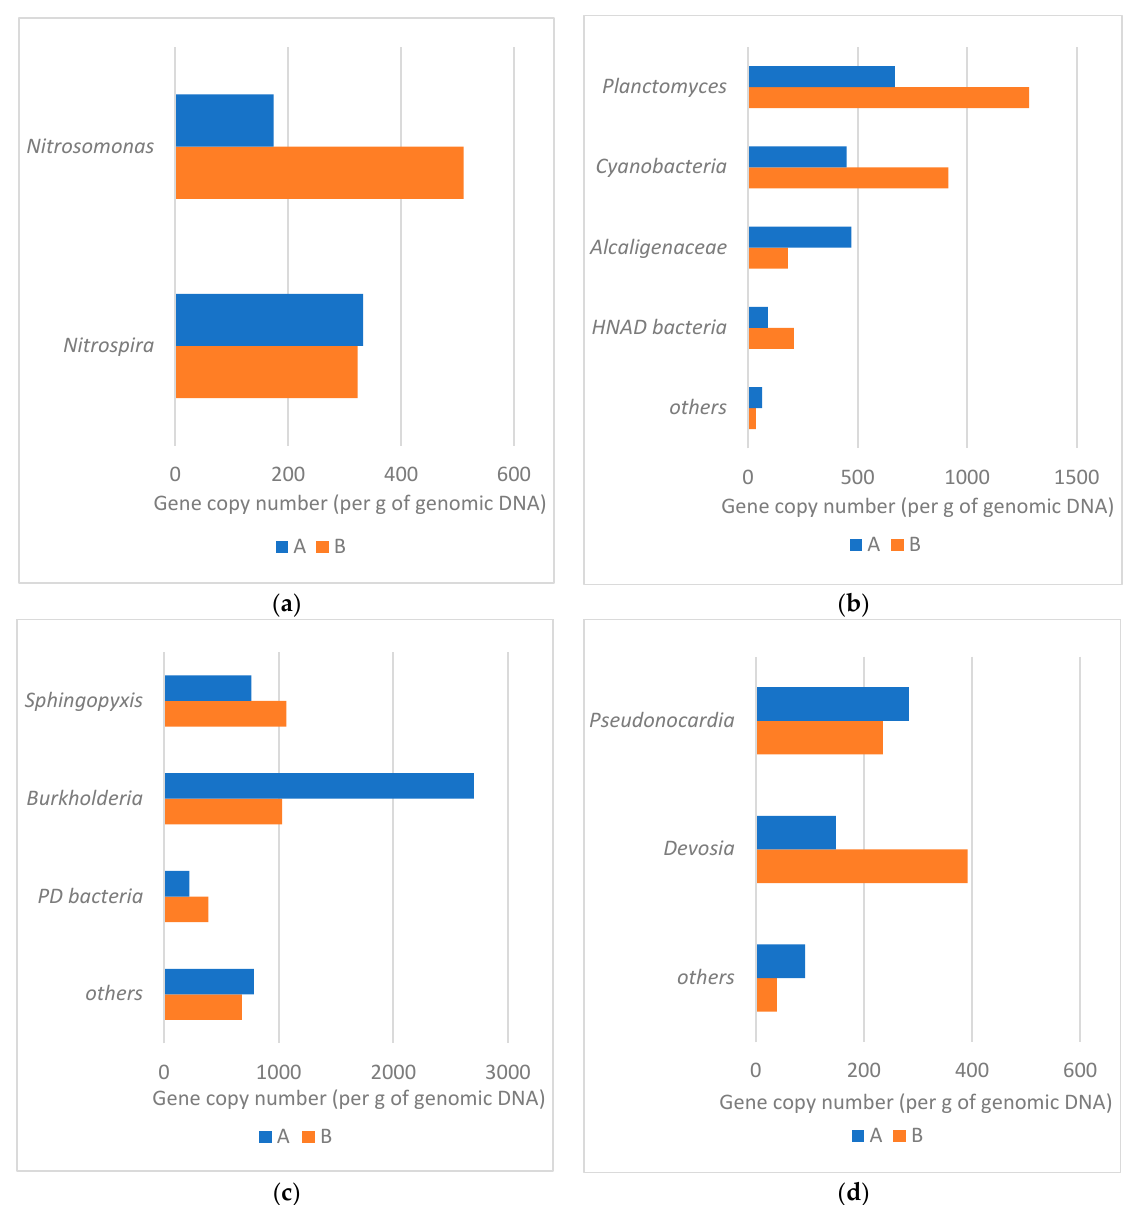
Figure 9. Bacteria participating in the process of ( a ) nitrification, ( b ) nitrification + denitrification, ( c ) denitrification, ( d ) phosphorus removal.